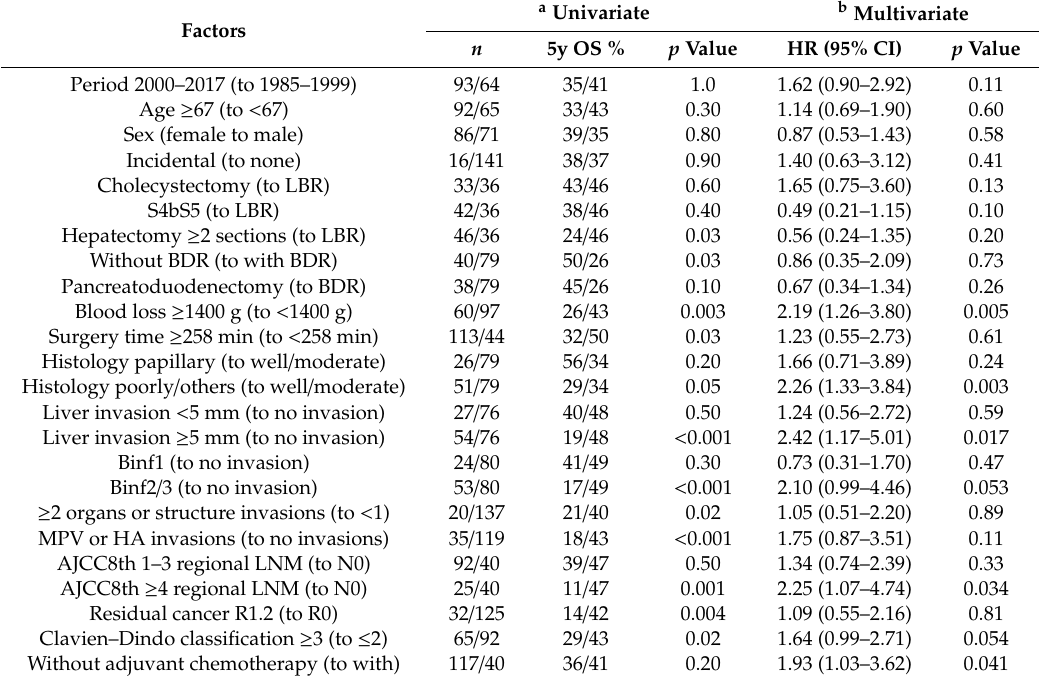
Table 2. Univariate and multivariate analyses of overall survival in patients with resected stage III-IV gallbladder cancer without distant